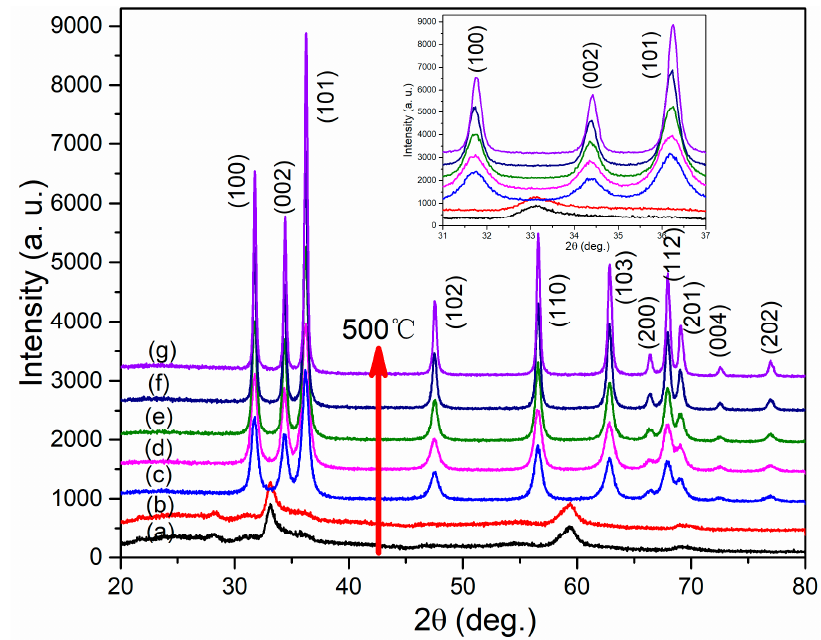
Figure 1. XRD patterns of hierarchical ZnO microspheres prepared at ( a ) RT, and annealed at ( b ) 200, ( c ) 300, ( d ) 350, ( e ) 400, ( f ) 450, and ( g ) 500 ◦ C. The inset shows an enlargement of the 31~37 ◦ region.